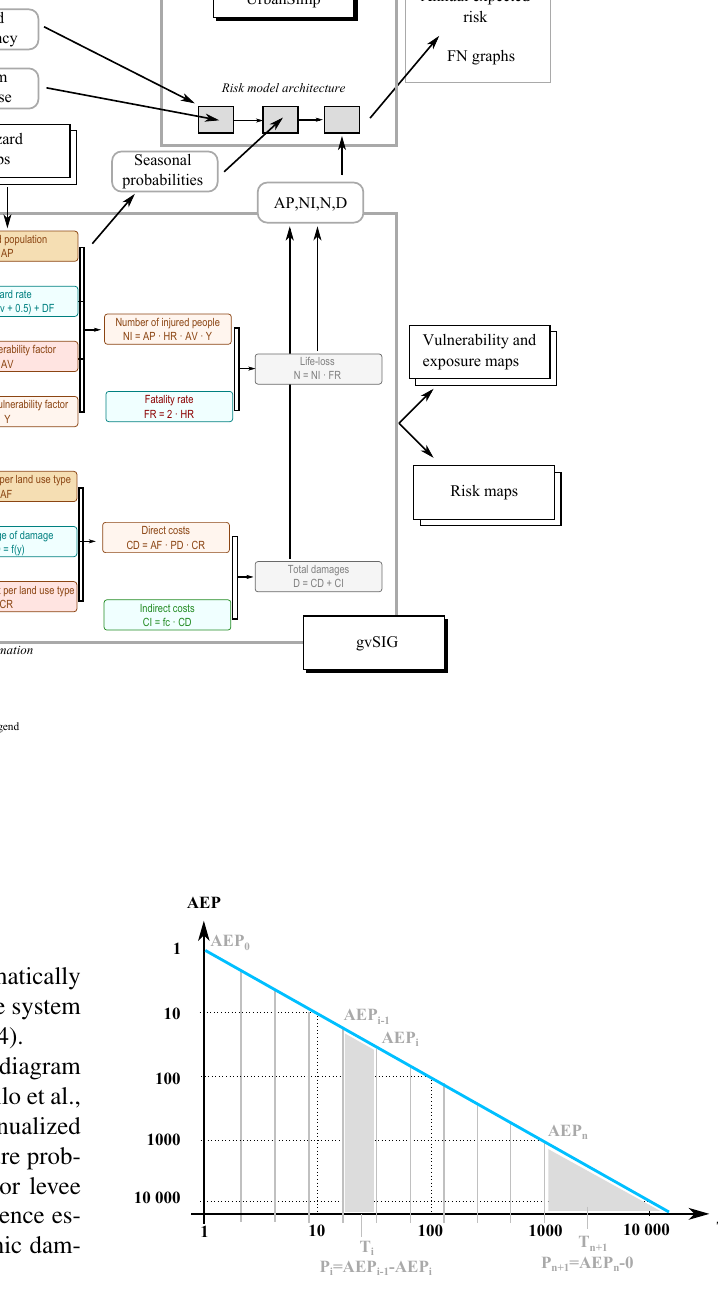
Figure 2. Generic division of the analysed range of flood